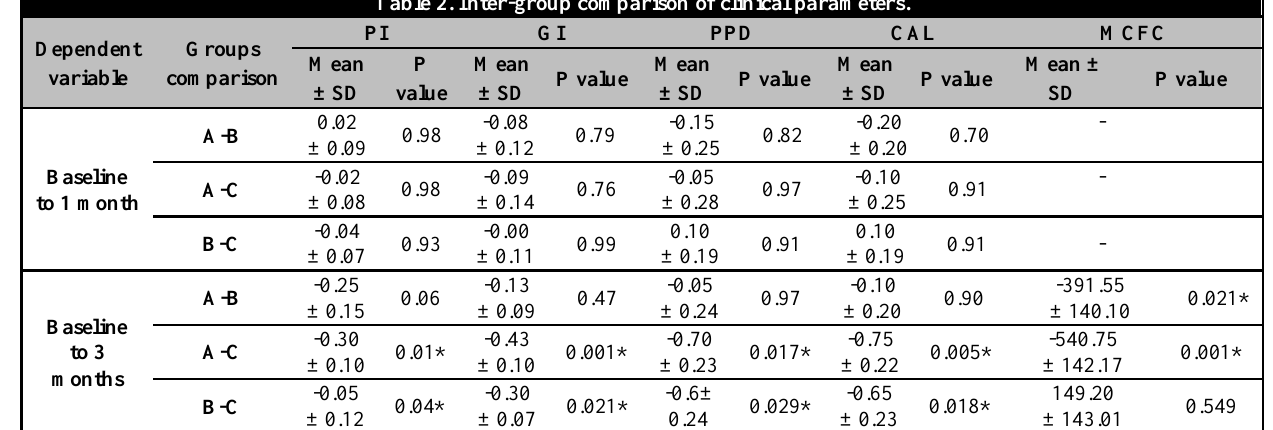
Table 2. Inter-group comparison of clinical parameters.